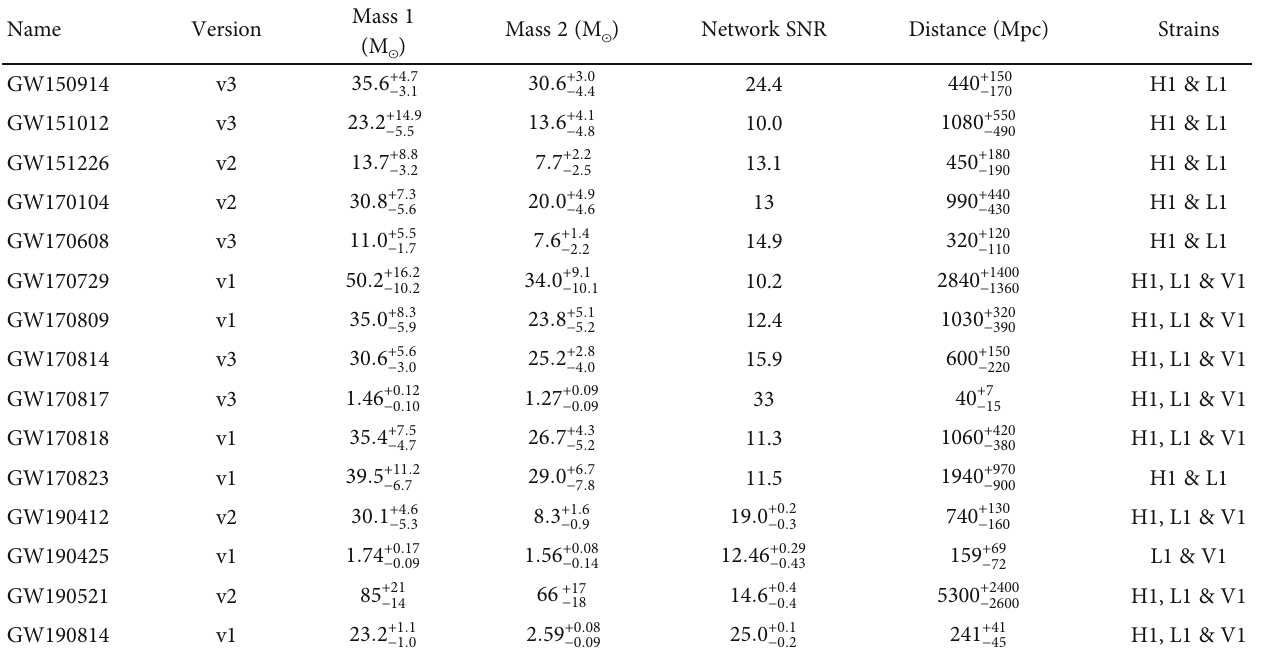
Table 1: The list of GW data.